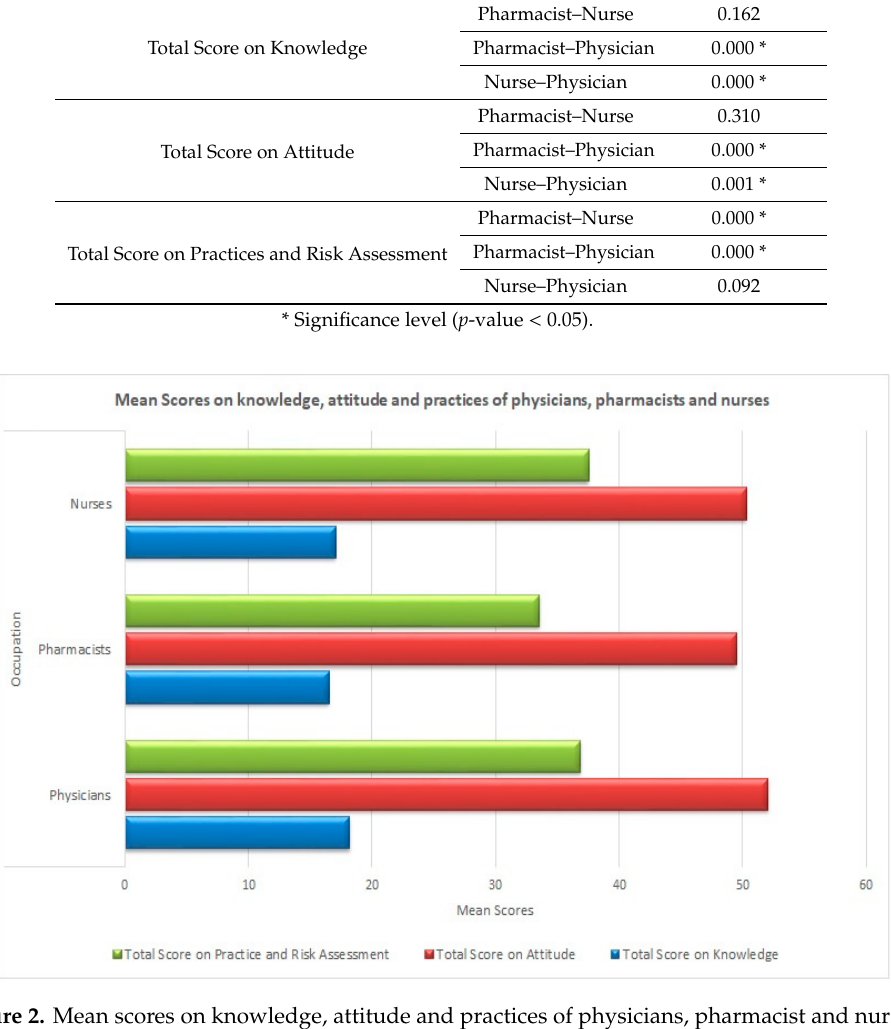
Figure 2. Mean scores on knowledge, attitude and practices of physicians, pharmacist and nurses.